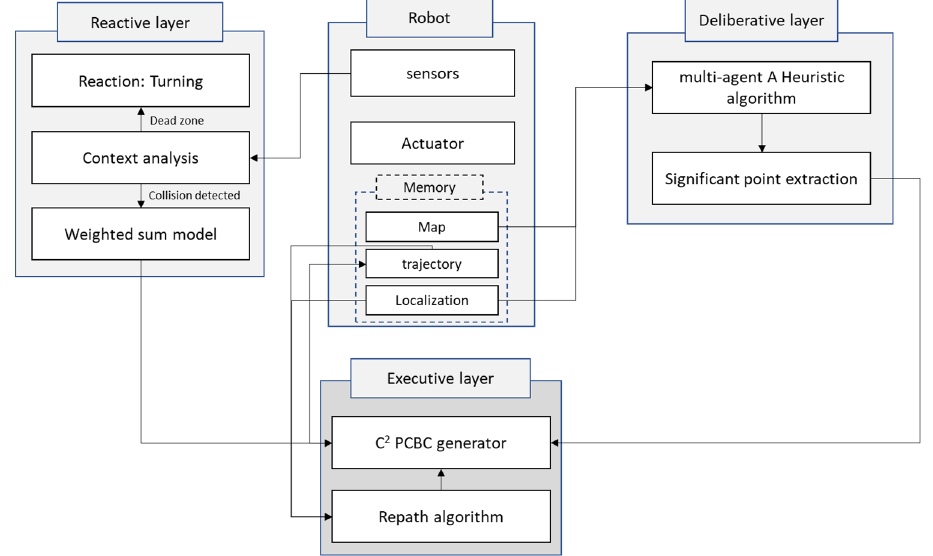
Figure 1. Flowchart of our proposed hybrid navigation system.